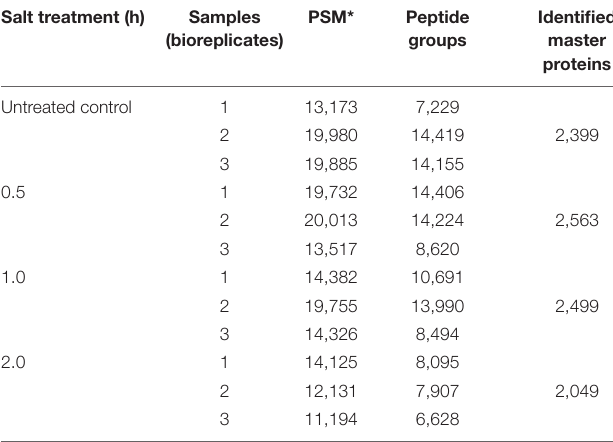
TABLE 2 | Summary of soybean C08 leaf proteome before and after salt treatment. Salt treatment